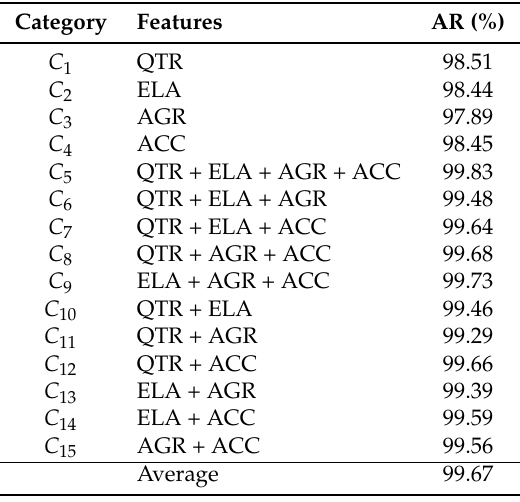
Table 3. Accuracy rates of the trained RNN models using different categories of IMU data with hold-out validation.